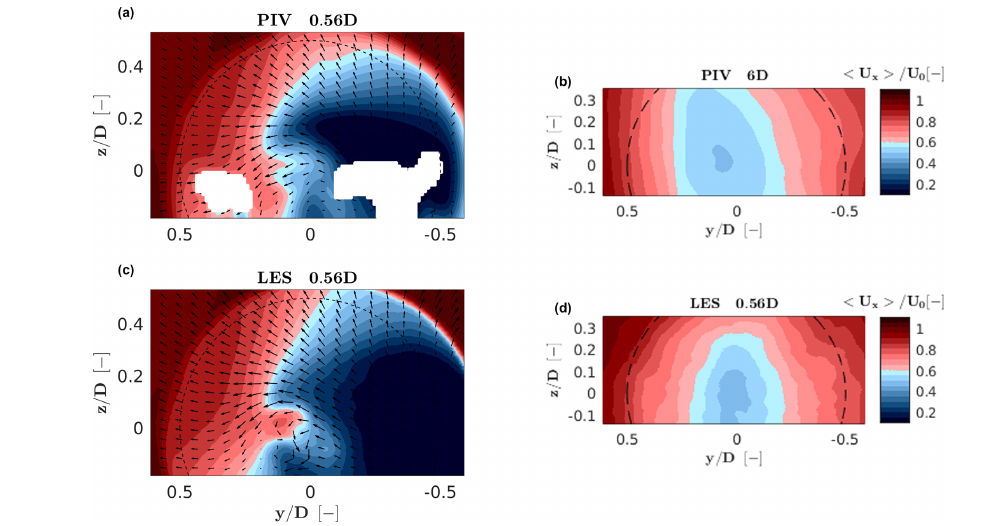
Figure 8. Streamwise velocity contour plots for the PIV measurements (a, b) and LES model (c, d) measured 0.56D (a, c) and 6D (b, d) downstream of the rotor. Black arrows indicate the crosswind velocity component at a number of sampling